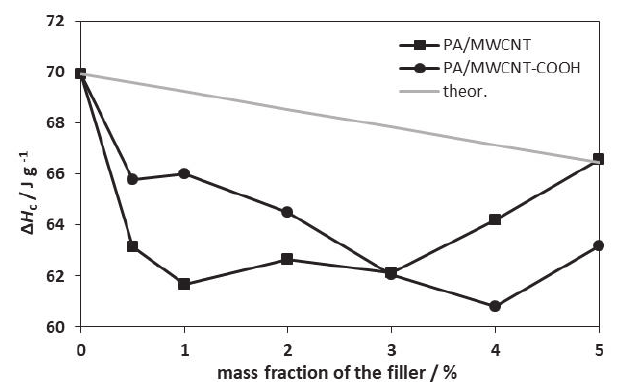
Fig. 4 – Crystallization enthalpy of PA/MWCNT and PA/ MWCNT-COOH nanocomposites